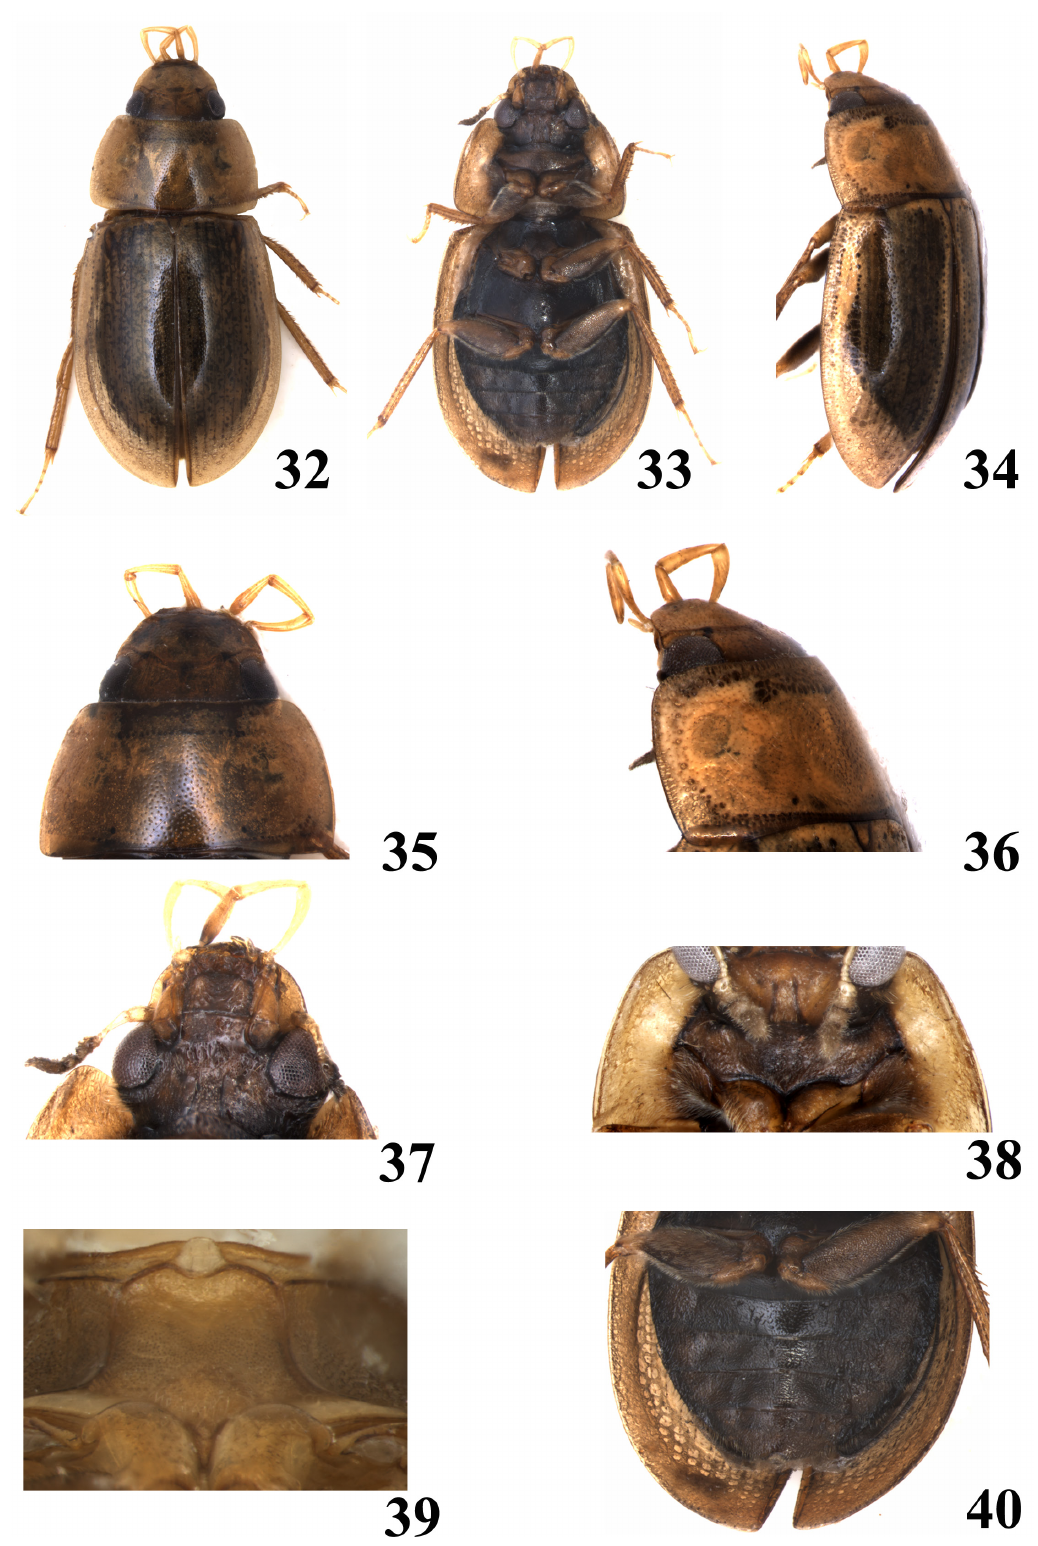
Figs 32–40. Helochares pallens (MacLeay, 1825). 32–34 . Habitus. 32. Dorsal. 33. Ventral. 34. Lateral. 35 . Head and pronotum. 36 . Pronotum, dorsolateral. 37 . Head, ventral. 38 . Prosternum. 39 . Mesoventrite with legs. 40 .